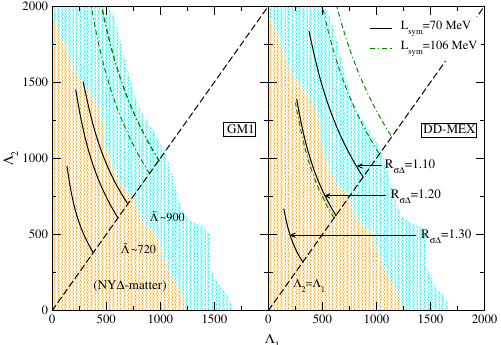
Figure 2. Tidal deformability parameters corresponding to the primary and secondary components involved in GW170817 event for various isospin dependent coupling in =1.30DD-MEX accordance to PREX-2 and alterations in R σ ∆ − R ω ∆ . Here, we have considered the chirp mass to be M = 1 . 186 M ⊙ . The shaded regions denote the tidal deformability upper bounds of ˜ Λ ∼ 900 [15] (cyan) and ˜ Λ ∼ 720 [17]